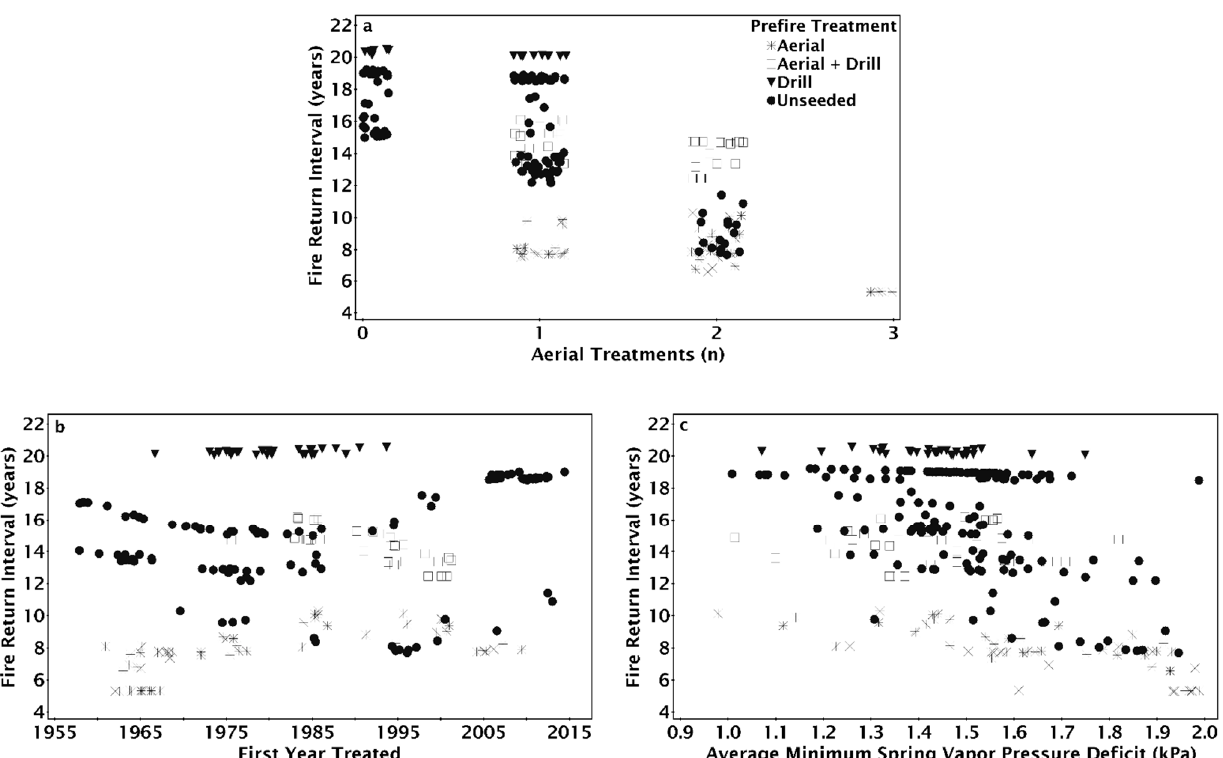
Figure 6. The modeled relationship between the fire return interval grouped by the type of pre-fire Scheme 30. year average spring vapor pressure deficit. Figures include 5% jittering along the x-axis ( a ) or y-axis ( b,c ) was used to see overlapping treatments.